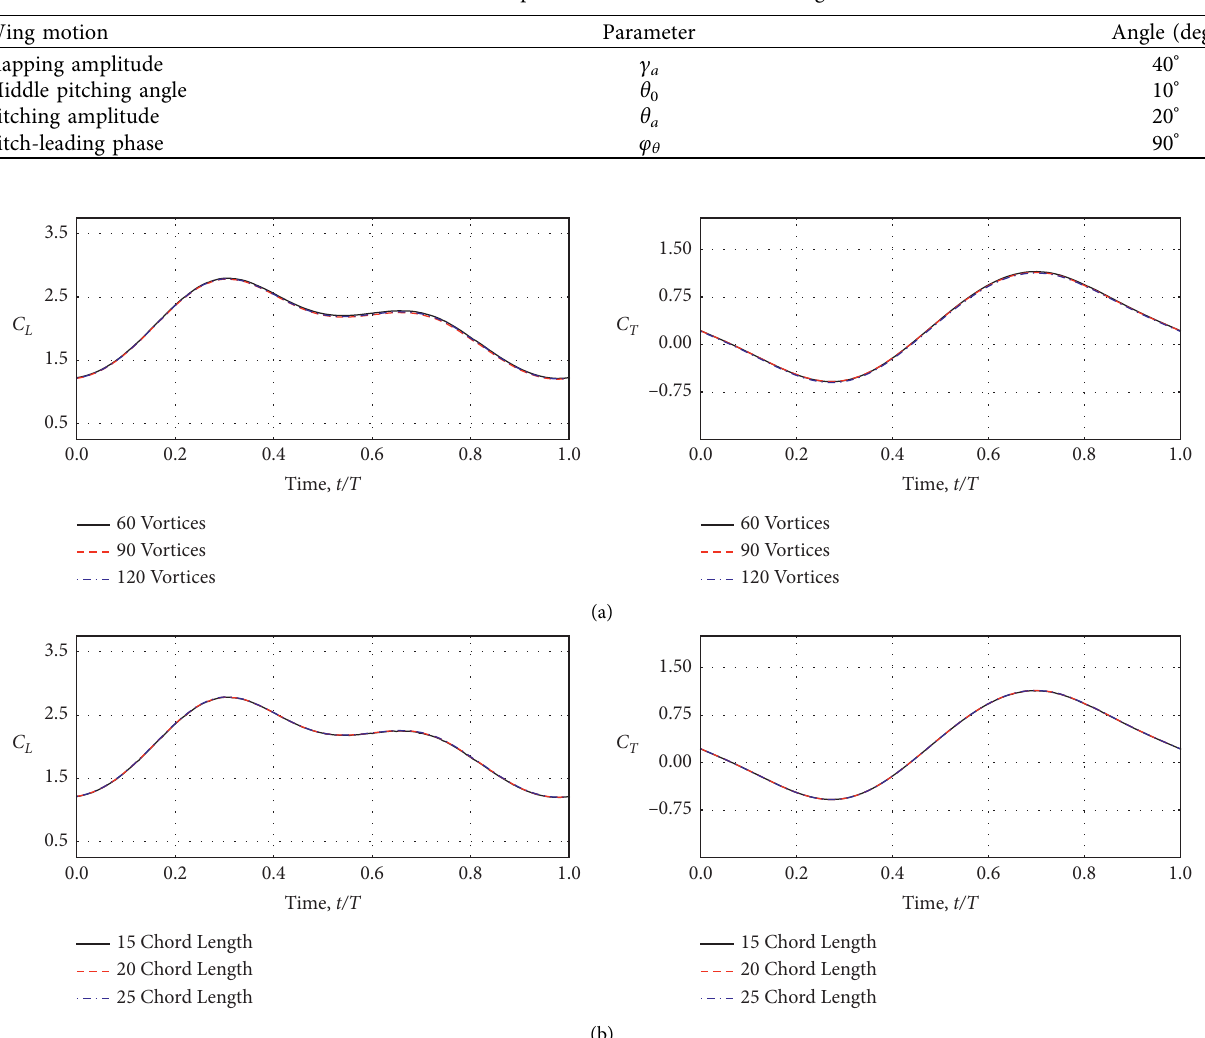
Table 2: Kinematic parameter in the UVLM convergence.